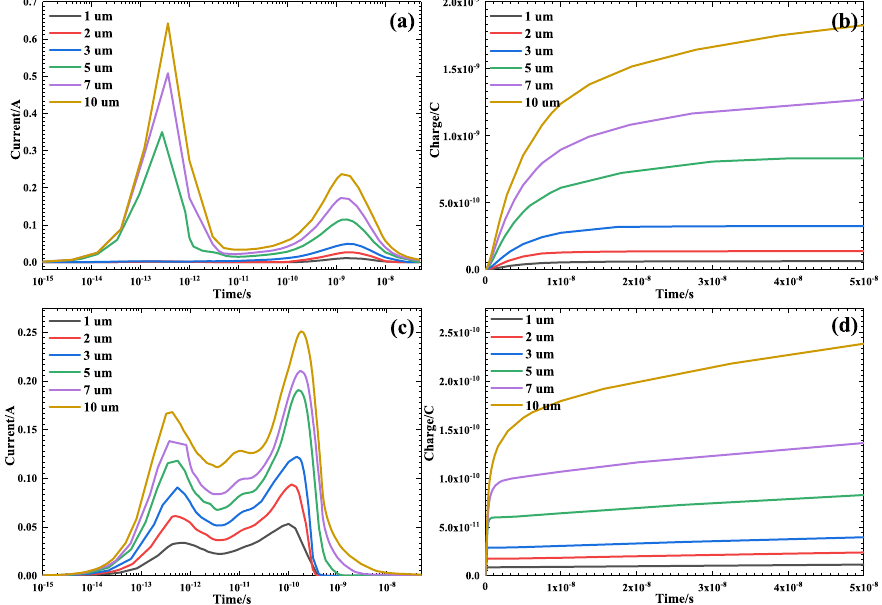
Figure 11. Change in collector current and collected charge with time when heavy ions with different projected range vertically irradiate the collector ( a , b ) and substrate ( c , d ) of the SiGe